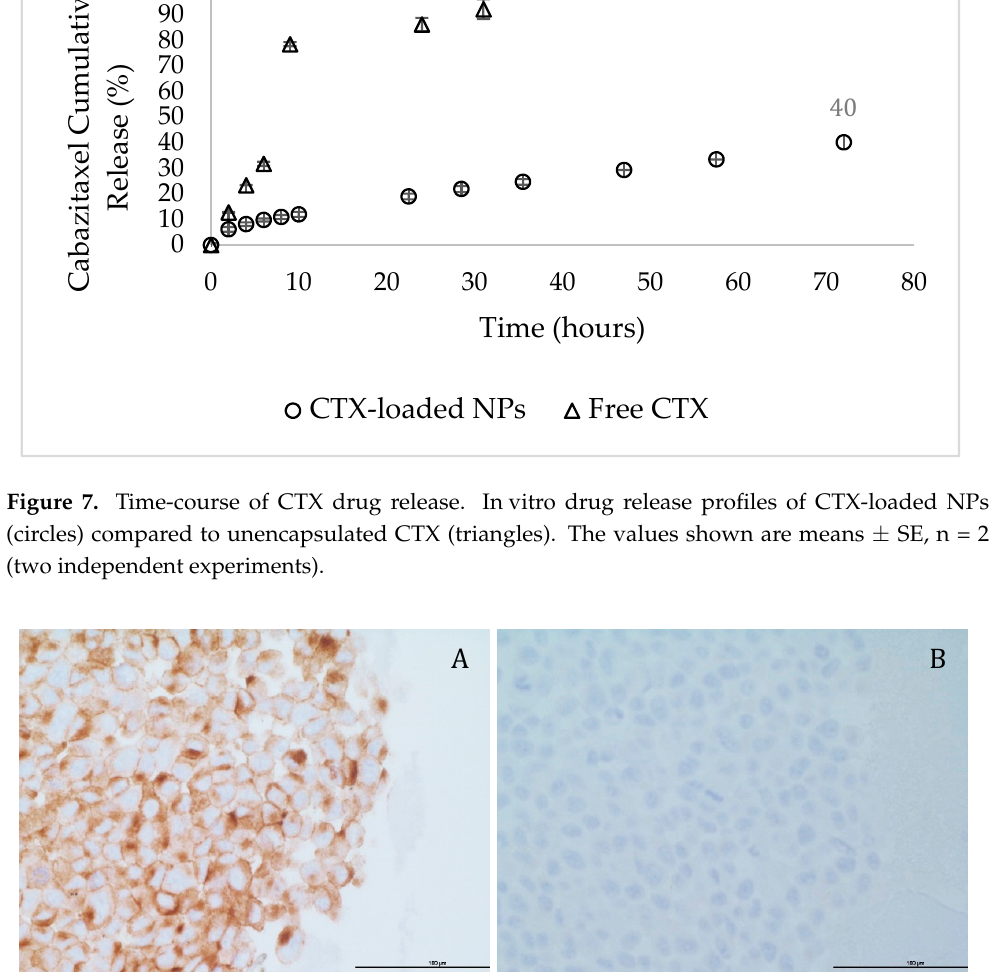
Figure 7. Time-course of CTX drug release. In vitro drug release profiles of CTX-loaded NPs (cir- cles) compared to unencapsulated CTX (triangles). The values shown are means ± SE, n = 2 (two independent experiments).